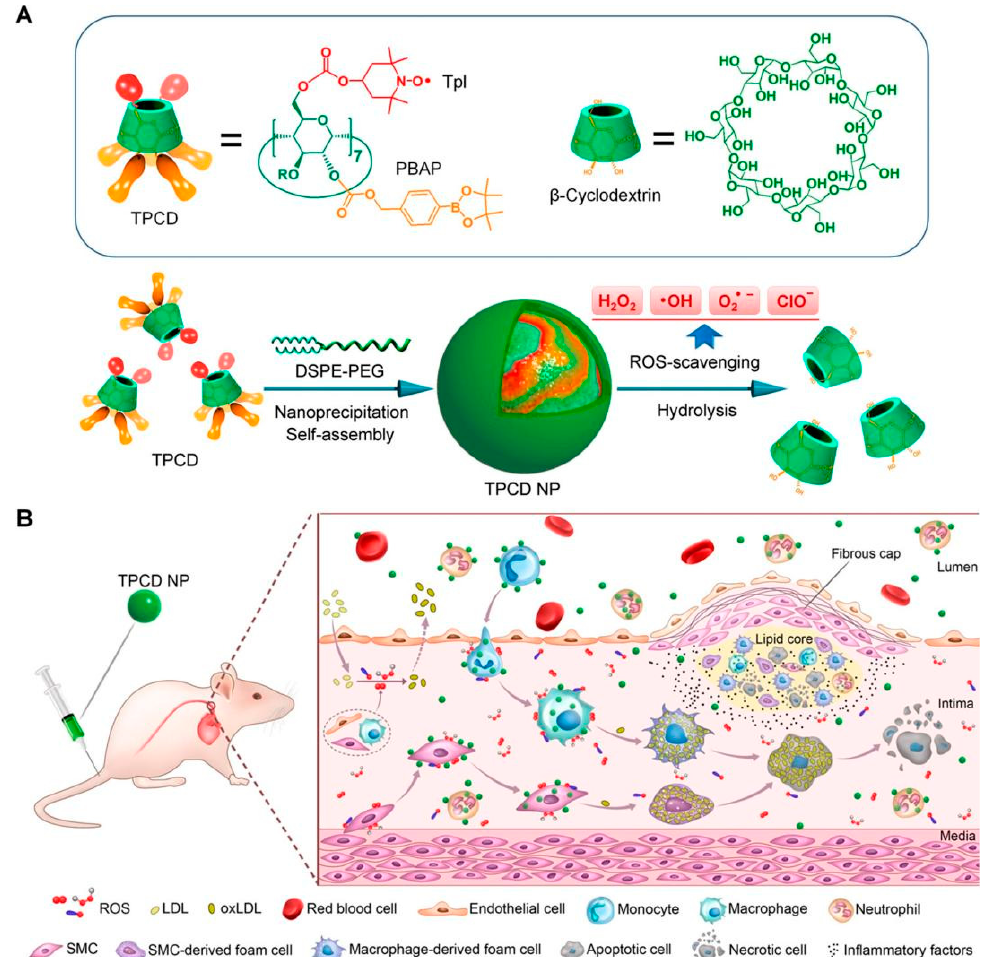
Figure 3. Schematic of engineering a broad-spectrum ROS-scavenging nanoparticle and targeted therapy of AS. ( A ) Chemical structure of a broad-spectrum ROS-eliminating material TPCD and development of a TPCD nanoparticle (TPCD NP). ( B ) Sketch of targeted treatment of AS by eliminating ROS through i.v. administration of engineered TPCD NP. Reprinted with permission from ACS nano. Wang, Y., et al., Targeted Therapy of Atherosclerosis by a Broad-Spectrum Reactive Oxygen Species, pages 8943–8960. Copyright 2018 American Chemical Society [55].